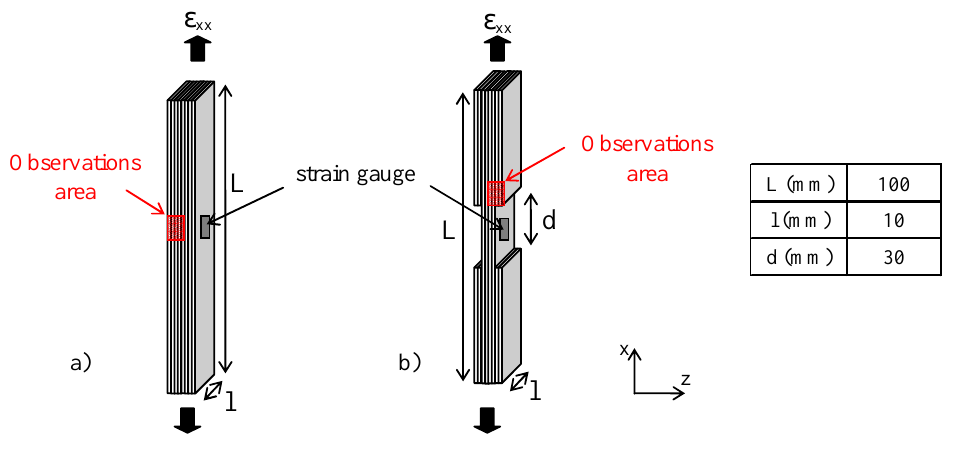
Fig. 2. Flat sample (a) sample with ply drops